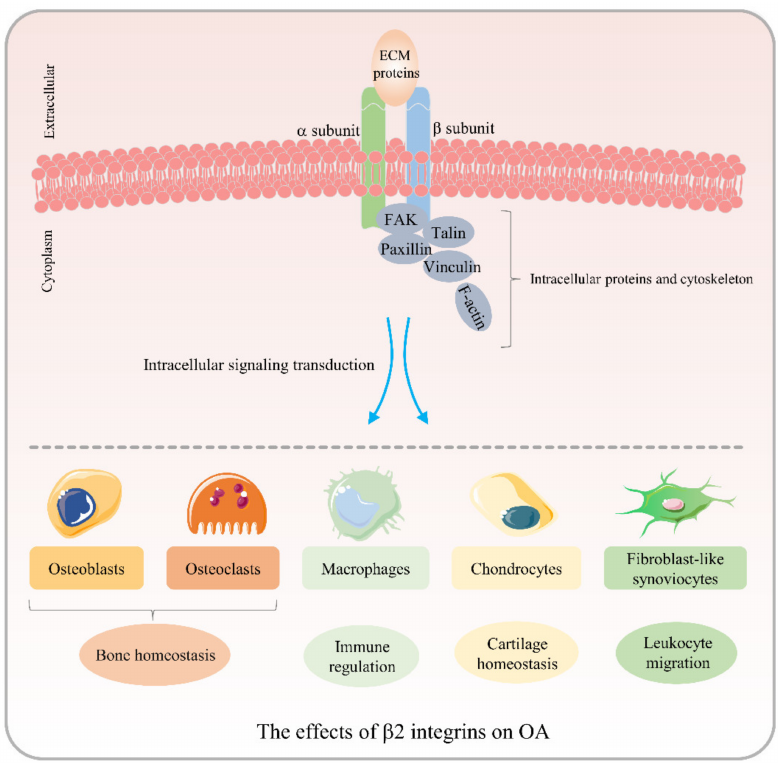
Figure 3. Schematic representation of the roles of β 2 integrins in osteoarthritis (OA) pathogenesis. β 2 integrins interact with ligands on osteoblast surfaces and may serve a dual role in the differentiation and maturation of osteoclasts, thereby upsetting bone homeostasis in OA. β 2 integrins may